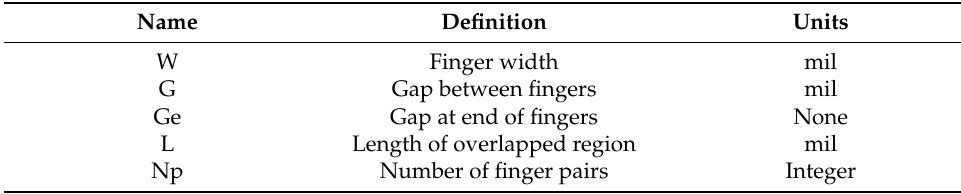
Table 2. Parameter of microstrip interdigital capacitor.